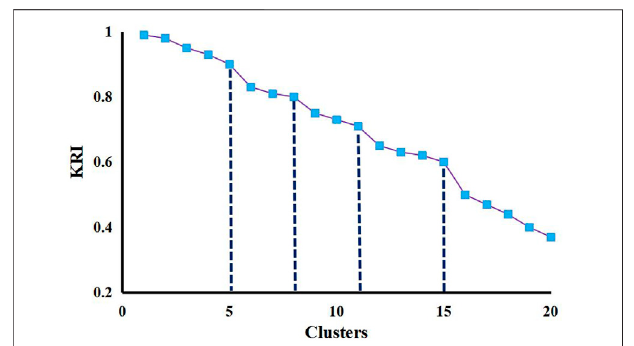
FIGURE 6 | Schematic diagram of determining the optimal number of logging facies by the